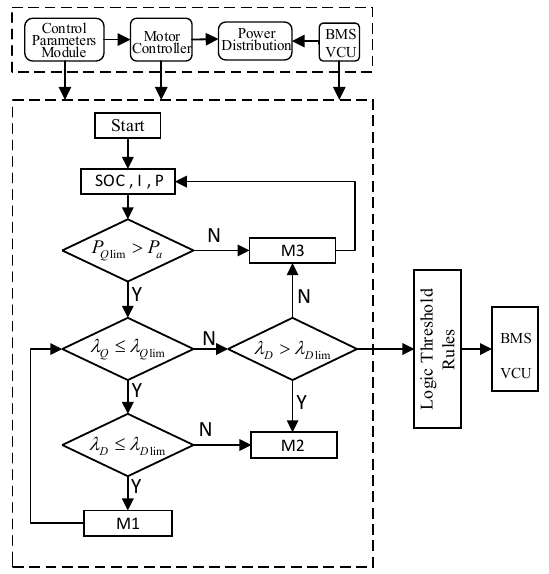
Figure 7. Logic rule ‐ based power allocation process.